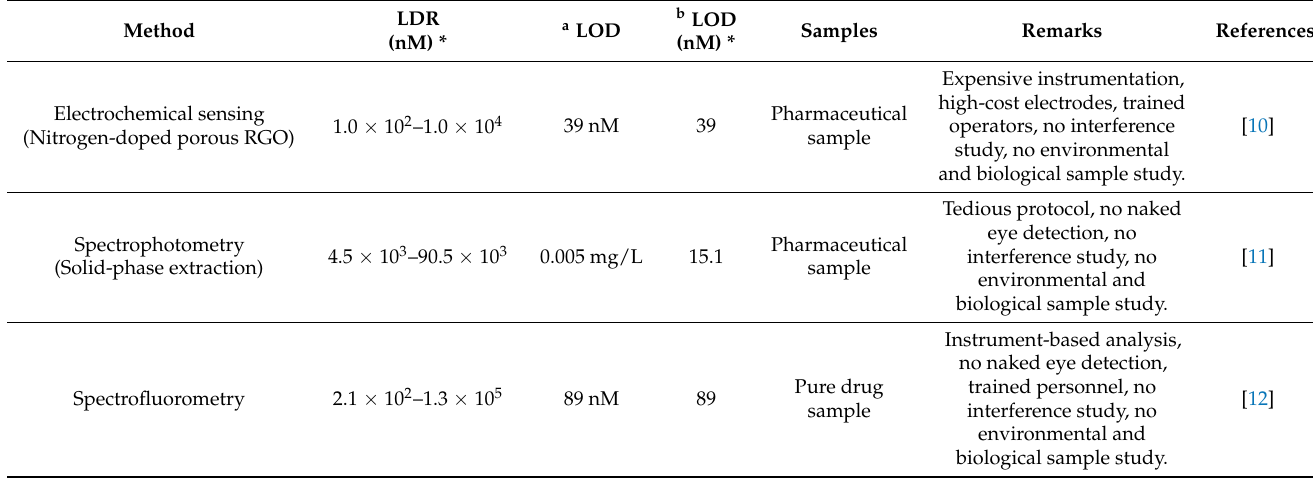
Table 1. Comparison of the analytical methods for the determination of CIP.